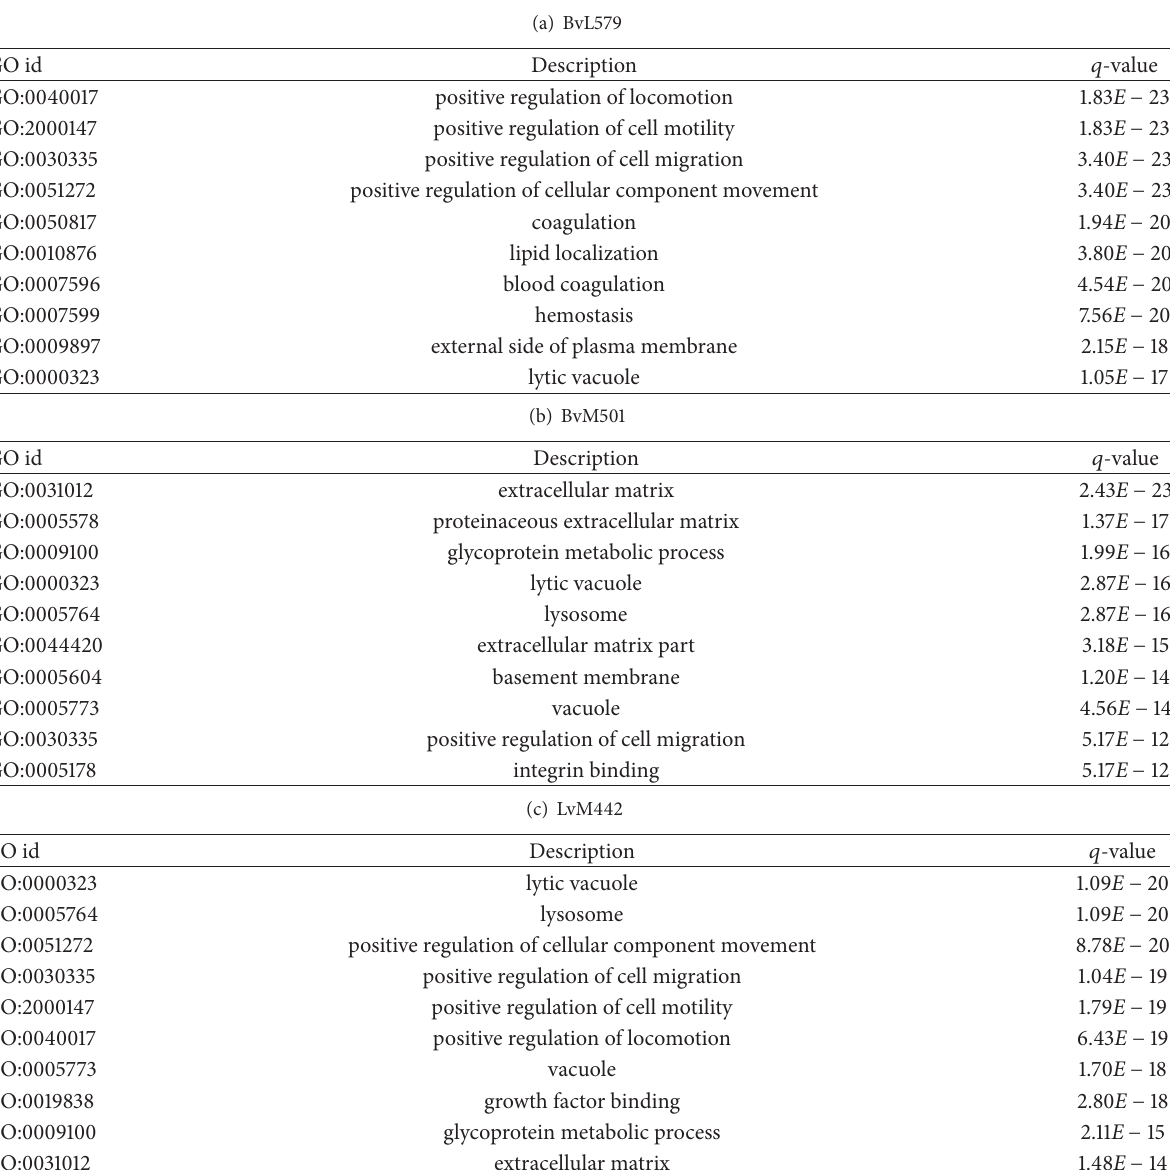
Table 4: 10 enriched gene ontology (GO) terms for DEGGs and additional related genes as reported by GeneMANIA for each category